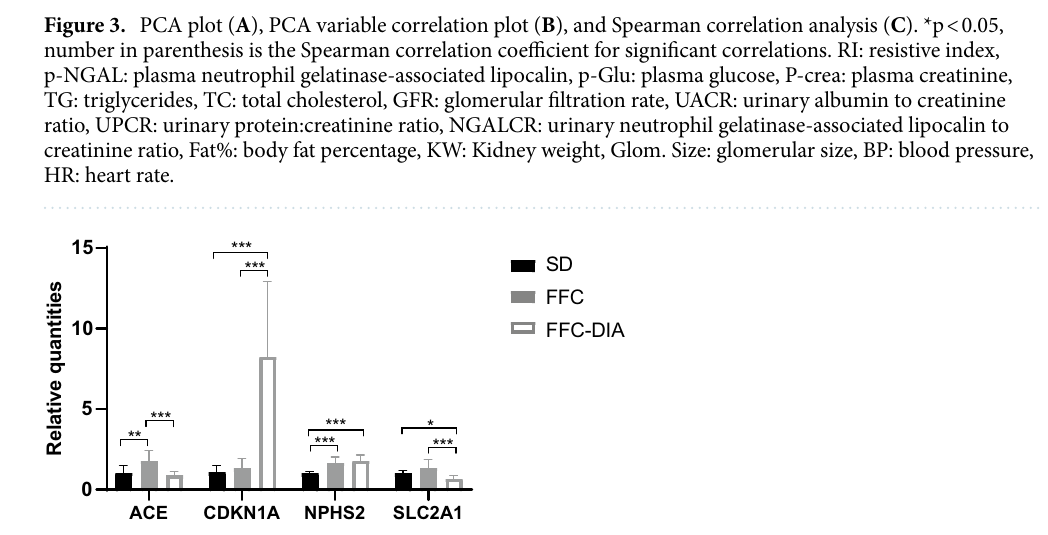
Figure 4. Gene expression data. Relative quantities of the 4 significantly deregulated genes (passing Bonferroni correction) in male, castrated Göttingen Minipigs fed with standard diet (SD, N = 7) or fat, fructose and cholesterol rich diet without induction of diabetes (FFC, N = 13) or with induction of diabetes (FFC-DIA, N = 8). Data are shown as mean ± SD, *p < 0.05, **p < 0.01, ***p < 0.001. Angiotensin I converting enzyme ( ACE ),